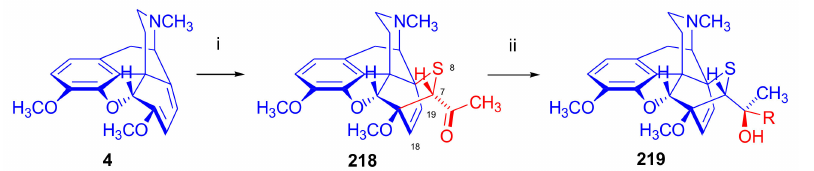
Figure 59. Synthesis of 20-alkyl-8-thiathevinols. Reagents and conditions : (i): (A) AcCH 2 SSO 3 Na, Et 3 N, EtOH-benzene 1:1 (v/v), room temperature, 160 h, 42% or (B) AcCH 2 SSO 2 Tol, CaCl 2 · 2H 2 O, benzene, EtOH, 120 h, 75%; and (ii): RMgX, benzene or toluene, Et 2 O,